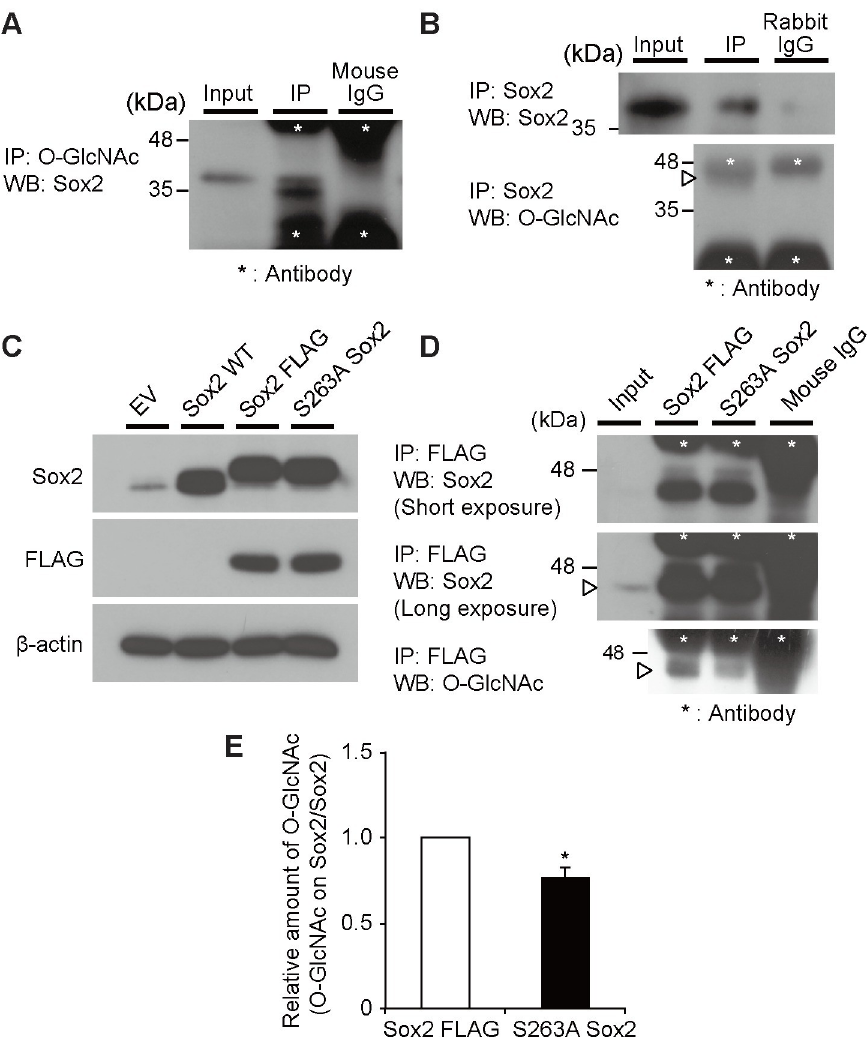
Fig 5. Sox2 is O-GlcNAcylated on S263 in mouse ESCs. (A) Representative image of a Western blotting using an anti-Sox2 Ab on the immunoprecipitated fraction (IP) precipitated with an antibody against O-GlcNAc (RL2). The input represents the total mouse ES cell lysate. Similar results were obtained in three independent experiments. (B) Representative image of a Western blotting using an anti-Sox2 Ab, anti-OGT Ab, and anti-O-GlcNAc Ab (RL2) on the immunoprecipitated fraction (IP) precipitated with an antibody against Sox2. The input represents the total ES cell lysate. The arrowhead indicates the Sox2 protein. Similar results were obtained in three independent experiments. (C) Representative image of Western blotting using an anti-Sox2 Ab, anti-FLAG Ab, and anti- β -actin Ab, in mES cells at 2 days after transfection with an empty vector (EV), Sox2 wild-type (Sox2 WT), Sox2 FLAG-tag (Sox2 FLAG), and Sox2 FLAG-tag S263A (S263A Sox2). Similar results were obtained in three independent experiments. (D) Representative image of immunofluorescence using anti-Sox2 Ab, in ES cells at 2 days after transfection with an empty vector (EV), Sox2 wild-type (Sox2 WT), Sox2 FLAG-tag (Sox2 FLAG), and Sox2 FLAG-tag S263A (S263A Sox2). (E) Band intensity of O-GlcNAc on Sox2 in (D) was normalized against total Sox2 and shown as fold change relative to Sox2 FLAG cells. The values are shown as means ± SEM of three independent experiments. Significant values are indicated as � p <